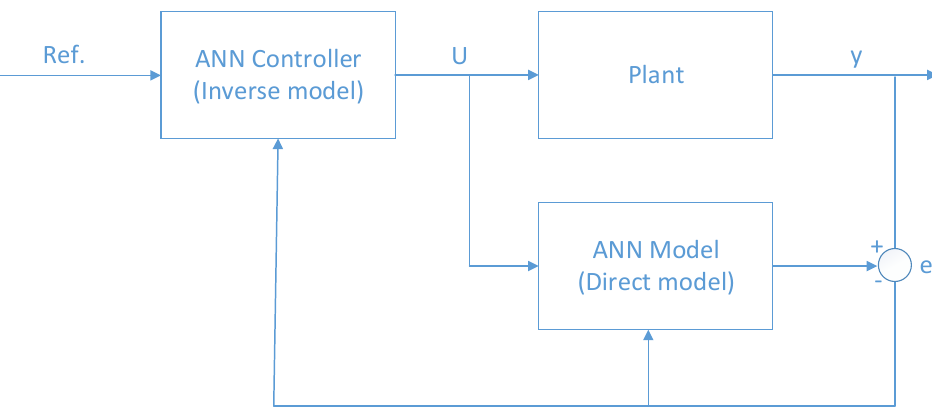
Figure 3. Direct inverse neural control.